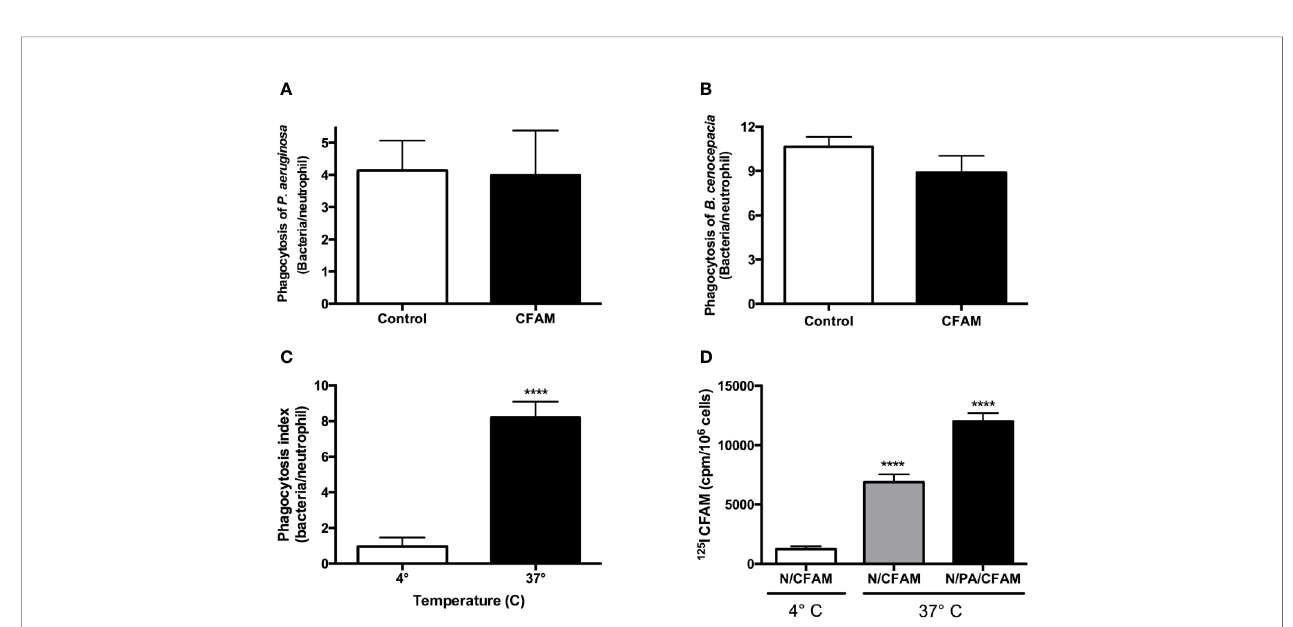
FIGURE 2 | Effect of CFAM on neutrophil-mediated bacterial phagocytosis and mucin adherence to resting and activated neutrophils. Pseudomonas aeruginosa (PAO1) and Burkholderia cenocepacia (C5424) bacteria were incubated 20 min at RT without (control) and with CFAM and added to human neutrophils in a ratio of 10 bacteria to 1 neutrophil for 1 h at 37°C. The phagocytosis indices for neutrophils exposed to (A) Pseudomonas aeruginosa (n = 6) and (B) Burkholderia cenocepacia (n = 5) were not different in the presence of 4 mg/ml of CFAM (p > 0.05). Opsonized Pseudomonas aeruginosa were incubated in the presence of 4 mg/ml CFAM and blood-derived neutrophils at 37 or 4°C for 1 h to determine the effect of temperature on (C) phagocytosis (n = 3), and on (D) 125 I-CFAM adherence or uptake by neutrophils (n = 3), determined by measuring the radioactivity of cell pellets after extensive washing. N/CFAM: neutrophils with CFAM; N/PA/ CFAM: neutrophils with Pseudomonas aeruginosa and CFAM. (**** P < 0.0001 vs.